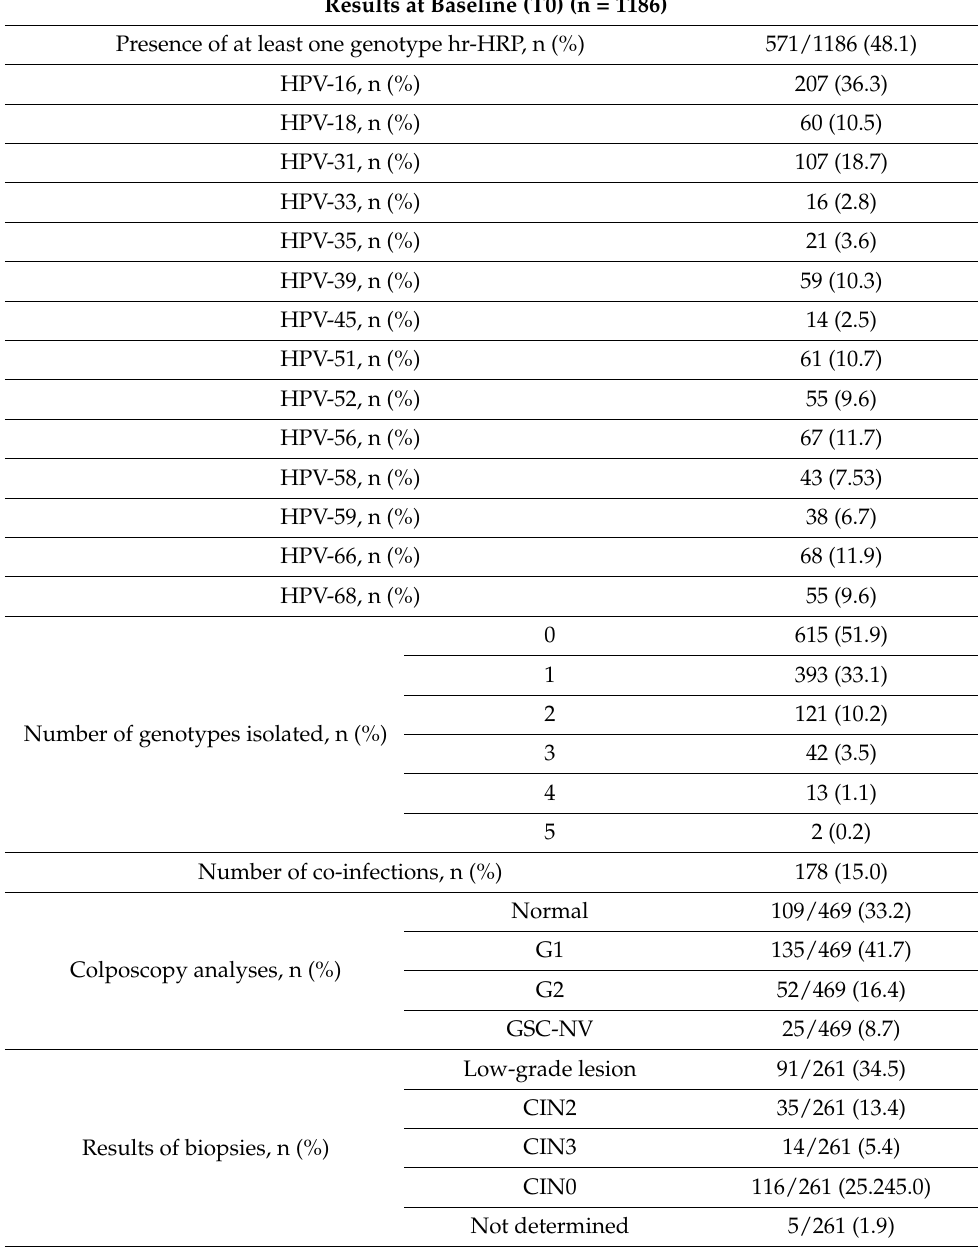
Table 2. Clinical and epidemiological characteristics at